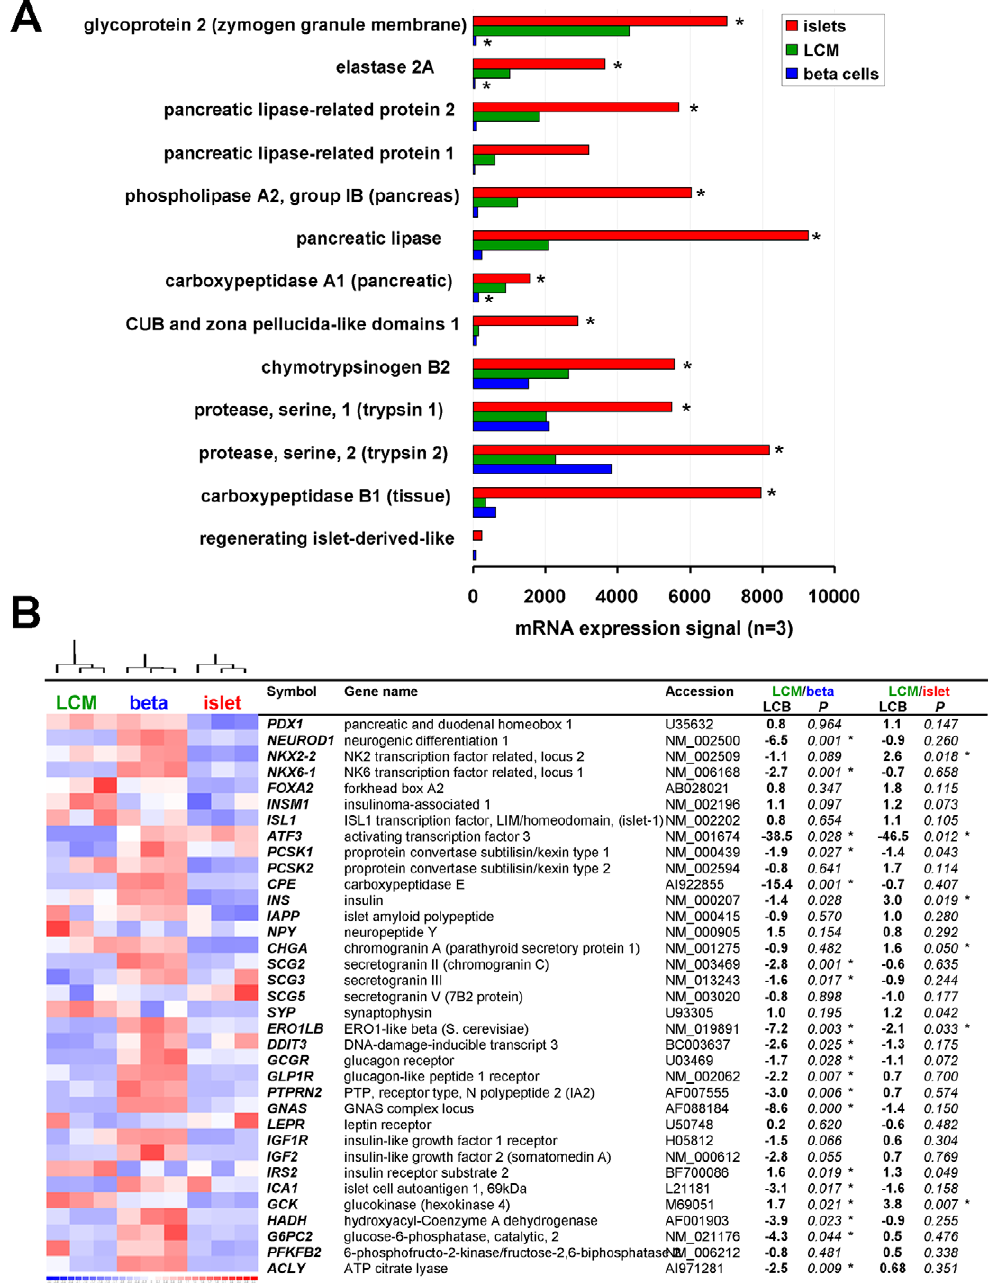
Figure 4. Conserved beta cell marker genes in isolated versus laser capture microdissected human beta cells. Panel A shows mRNA expression signal on HG133A chip of 13 established pancreatic exocrine (acinar) genes, in freshly isolated human islets (islets, red bars, n=3), laser capture microdissected beta cells (LCM, green bars, n=3) and 2–3 w cultured beta cells that were subsequently FACS-enriched (beta cells, blue bars, n=3). * p , 0.05 versus LCM. Panel B shows relative mRNA levels established beta cell-specific genes in cultured beta (blue), fresh islets (red) and LCM- beta cells (green). Table shows fold change (LCB, lower confidence bound) and P values of versus LCM-beta.